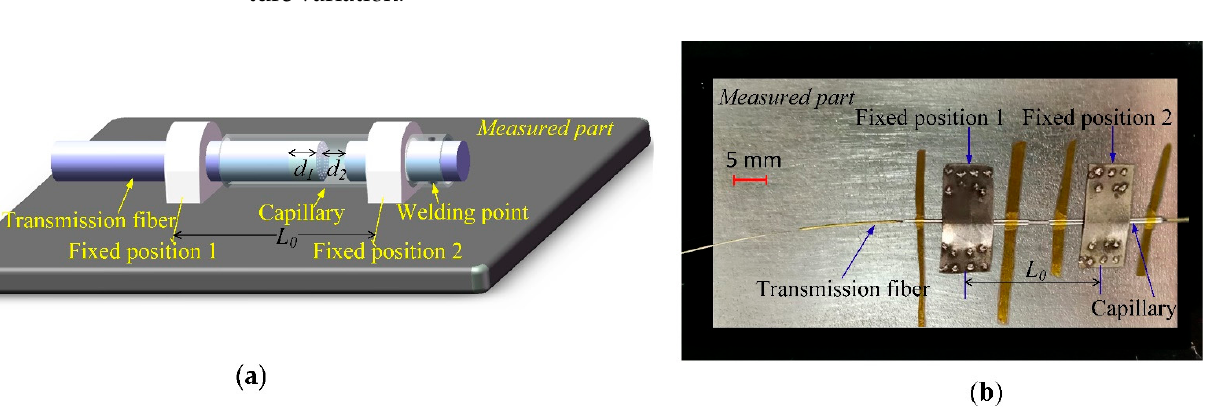
Figure 5. ( a ) Concept diagram of the sensor installation; ( b ) photograph of the sensor mounted on metal measured part by metal bonding.